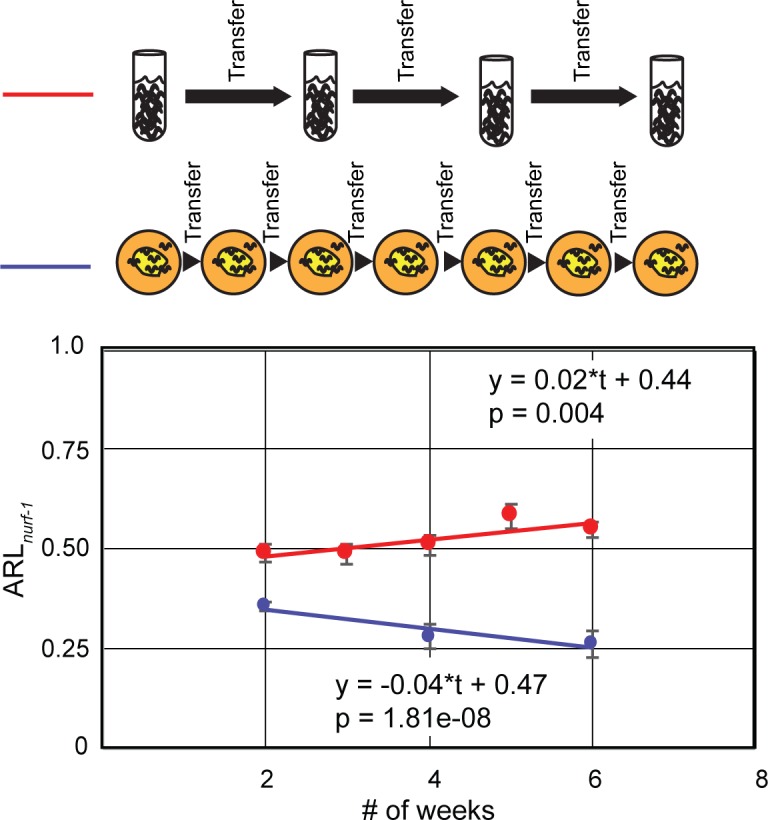
The 60 bp deletion in nurf-1 is advantageous in liquid axenic media but disadvantageous on agar plates.A diagram of the two competition conditions is shown above the graph. The ARLnurf-1 strain (PTM88) was competed against CX12311. The fraction of ARLnurf-1 animals in the population is shown on the y-axis. The equation for a linear regression fit is also shown on the graph. p value indicates significance of the temporal term by ANOVA. Error bars represent standard error.